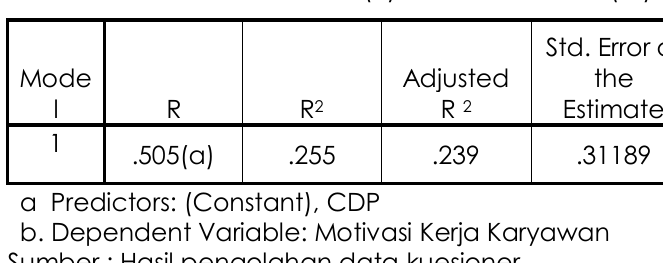
Tabel 1. Koefisien Korelasi (R) dan Determinasi (R 2 )